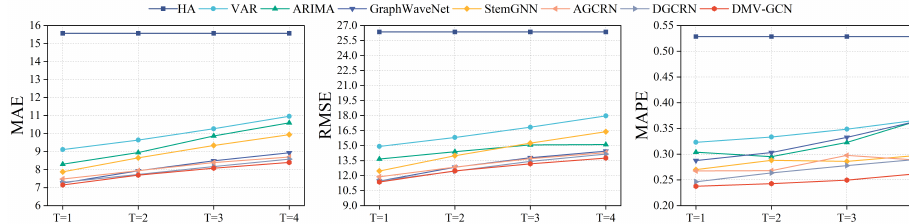
Figure 7. Comparison of the effect of different time-slice on NYC-taxi-2016.